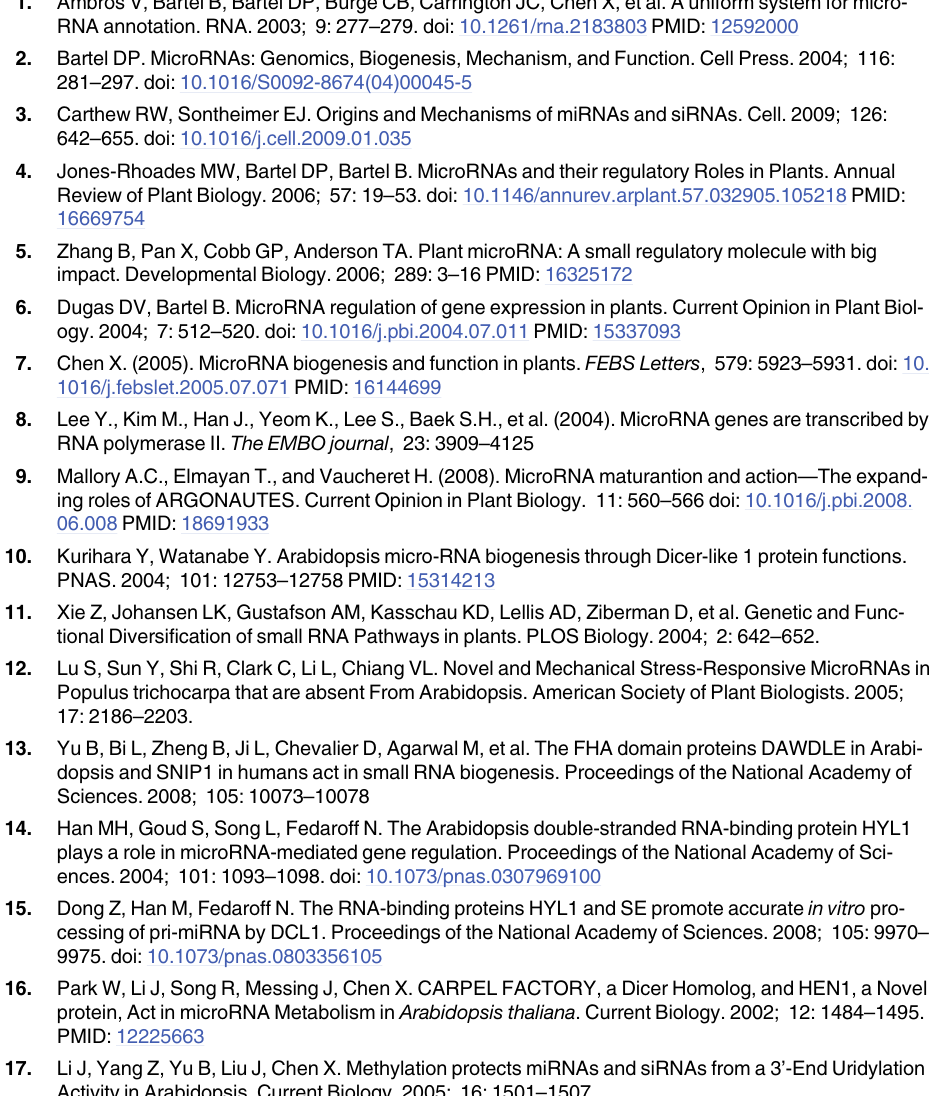
S8 Table. summary of the GO characterisation of the identified targets for the novel miR- NAs in terms of Biological process, Cellular components and Molecular function. S9 Table. Primer sequences used in this study for the RT-PCR experimental validation of the newly identified conserved and novel cassava